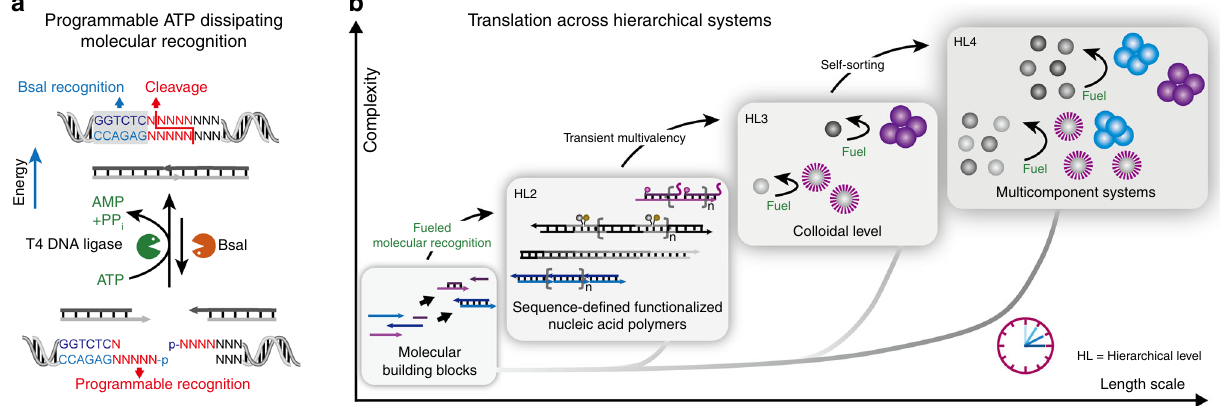
Fig. 1 Hierarchical transduction of non-equilibrium structures. a Illustration of the ATP-driven dynamic covalent DNA bond with fully programmable recognition, for which the lifetime is coupled to ATP fuel level, and in which the DySS properties are regulated by an enzymatic reaction network. b ATP- fueled modular DNA toolbox to engineer dissipative structures across 4D hierarchies, going from fuel-driven molecular recognition via sequence-de fi ned functionalized nucleic acid polymers and encoded multivalency to self-sorting 4D multicomponent colloidal systems. HL indicates the hierarchical levels. HL2 is formed solely based on the covalent nature of the reaction cycle, while HL3 uses the covalent structure on HL2 to achieve higher level supramolecular structures by